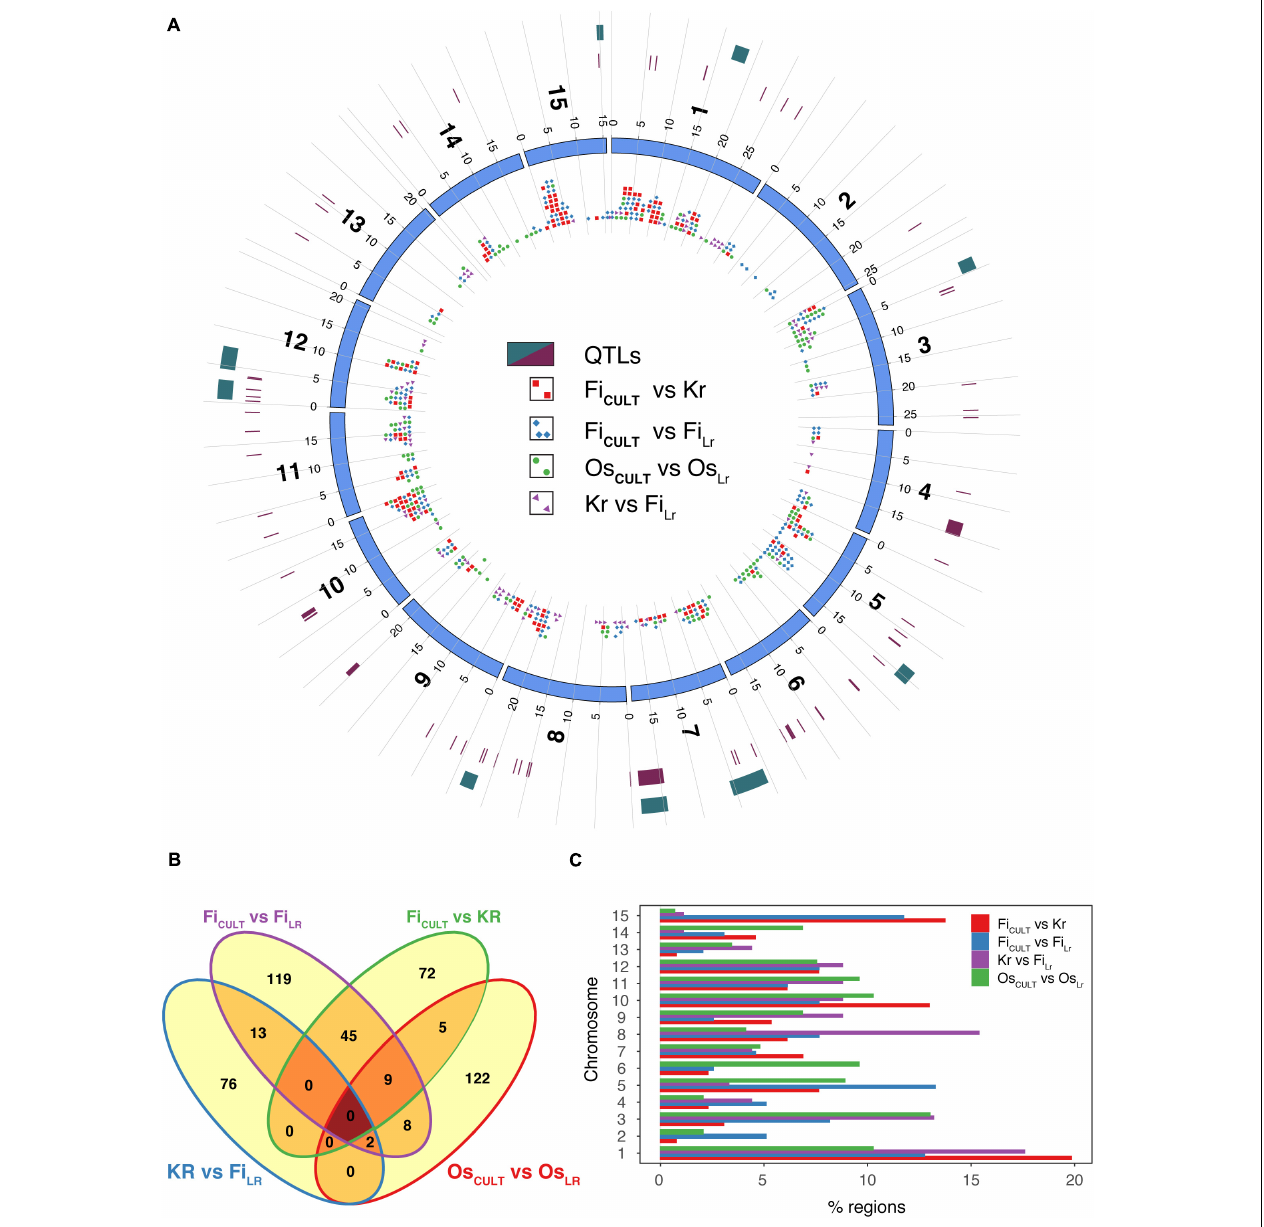
FIGURE 5 | Genomic regions under selection. (A) Circos diagram showing genome-wide selective sweep loci identified in different comparisons, with color codes assigned as follows: blue diamonds, fiber flax cultivars (Fi CULT ) vs. fiber flax landraces (Fi LR ); red squares, fiber flax cultivars vs. kryazhs (Kr); violet arrowheads, kryazhs vs. fiber flax landraces; and green dots, oilseed flax cultivars (Os CULT ) vs. oilseed landraces (Os LR ). Two outer rings depict (from inside to outside) known QTLs (22) shown as maroon rectangles, as well as QTLs overlapping with selective sweep regions (dark green rectangles). (B) Venn diagram shows the crossover of genomic regions under selection in different comparisons. (C) Fraction of candidate selection sweep regions identified in each comparison per chromosome. Color codes corresponding to different comparisons are identical to those used in panel (a)